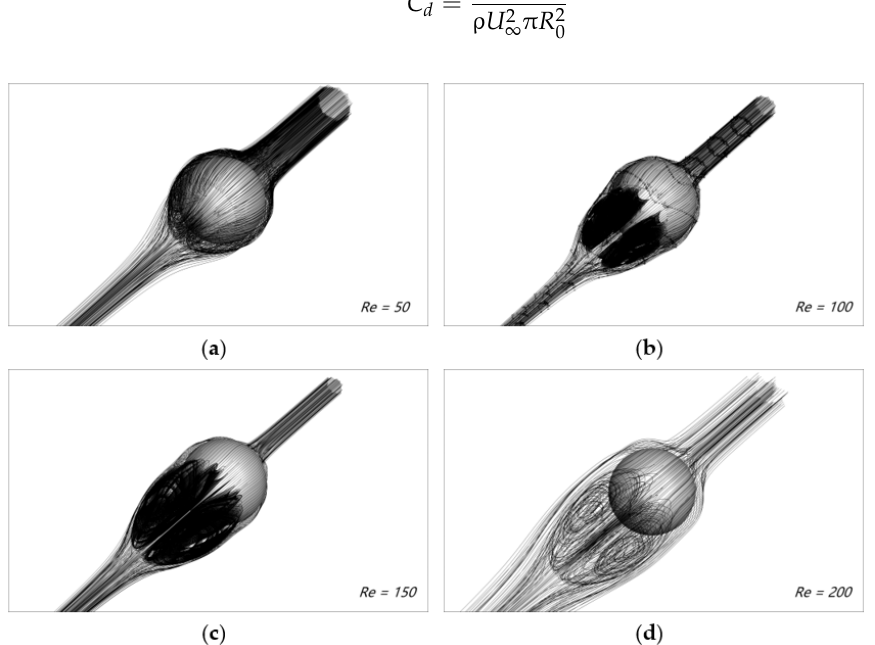
Figure 20. Streamlines of the flow field of a three-dimensional sphere at different Reynolds numbers.